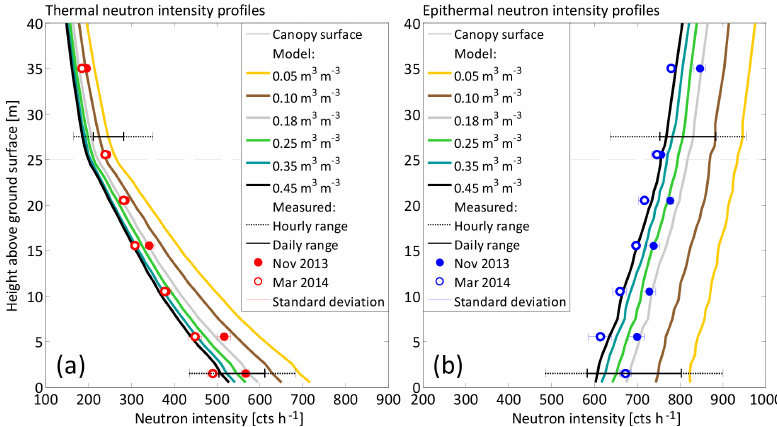
Figure 5. Sensitivity to volumetric soil moisture using model foliage. Measured and modeled (a) thermal and (b) epithermal neutron intensity profiles at Gludsted plantation. Hourly and daily ranges of variation of thermal and epithermal neutron intensities at ground and canopy level for the period